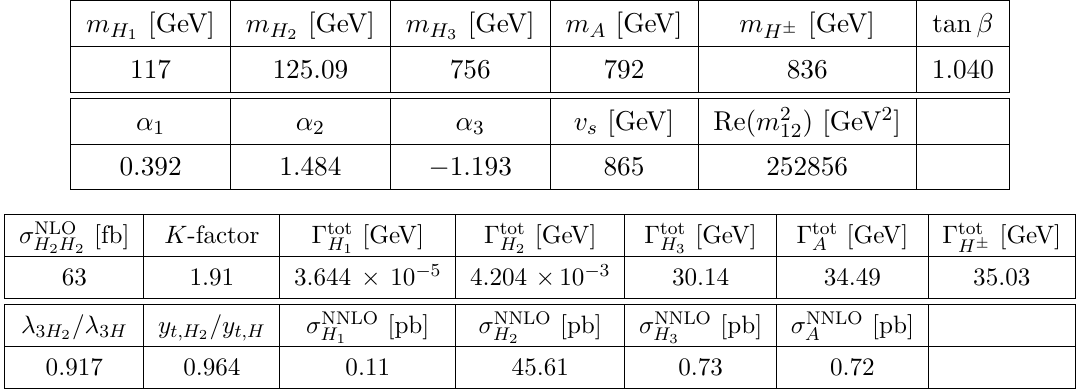
Table 16 . BP9 Upper: N2HDM-II input parameters. Lower: additional double and single Higgs production related